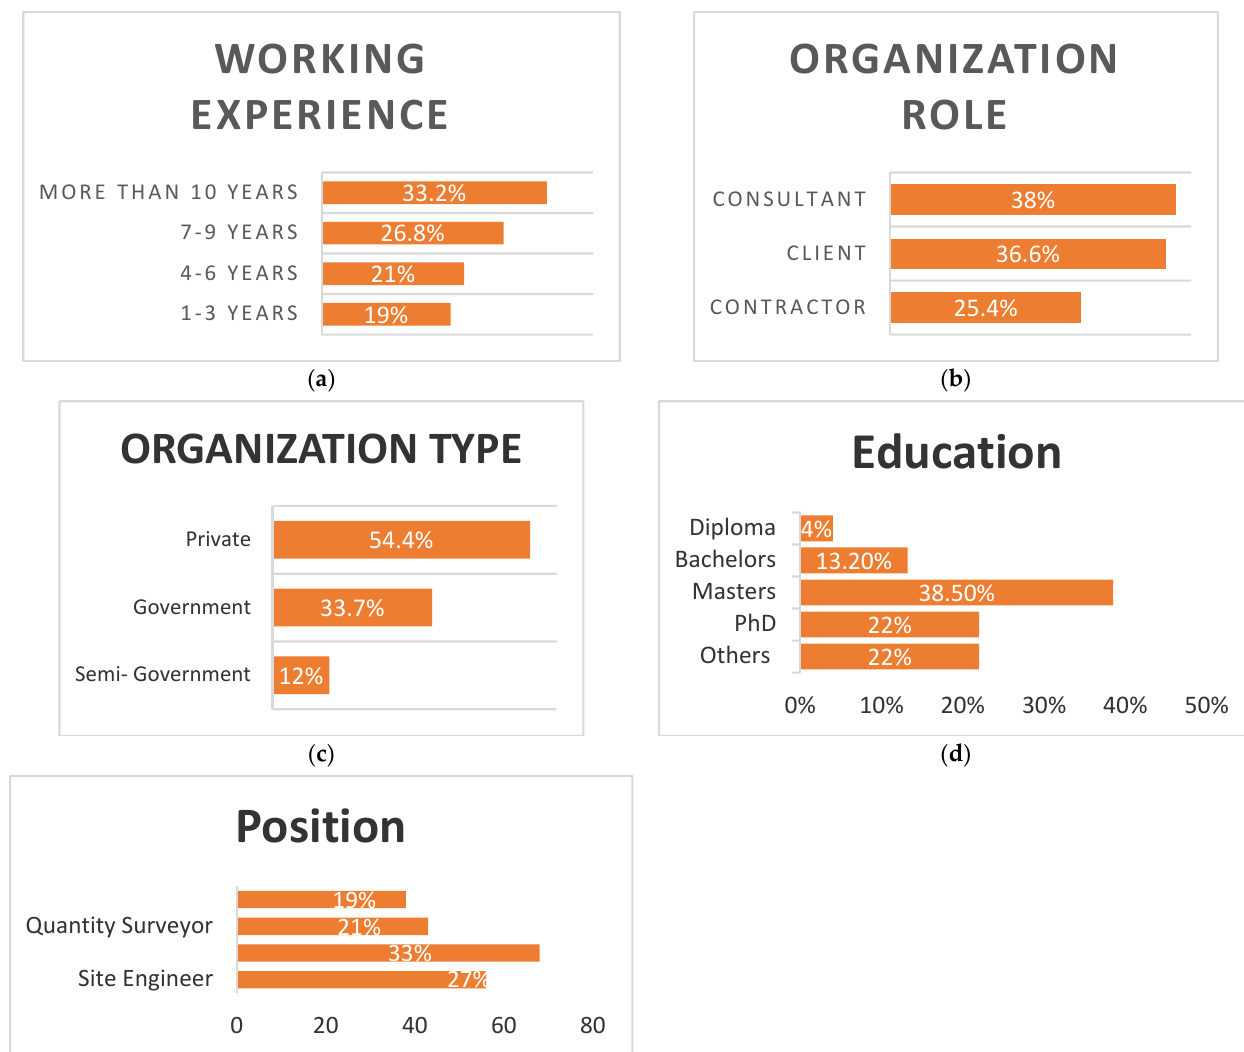
Figure 2. Breakdown of 205 returned questionnaires by the working experience, organizational role, organization type education, position ( a – e ).